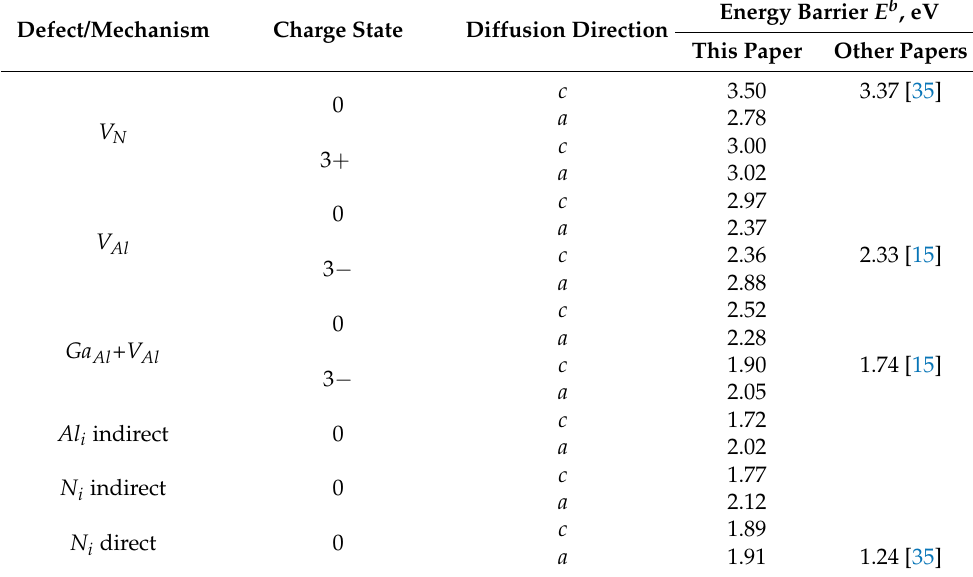
Table 2. Heights of the migration energy barriers in bulk wz-AlN. A positive charge state of the va- cancy represents the p -type dopant, while a negative one, the n -type dopant. Explanation of symbols: V N —nitrogen vacancy, V Al —aluminium vacancy, Ga Al + V Al —substitutional Ga atom in Al sublattice migrating towards aluminium vacancy, Al i —aluminium interstitial, N i —nitrogen